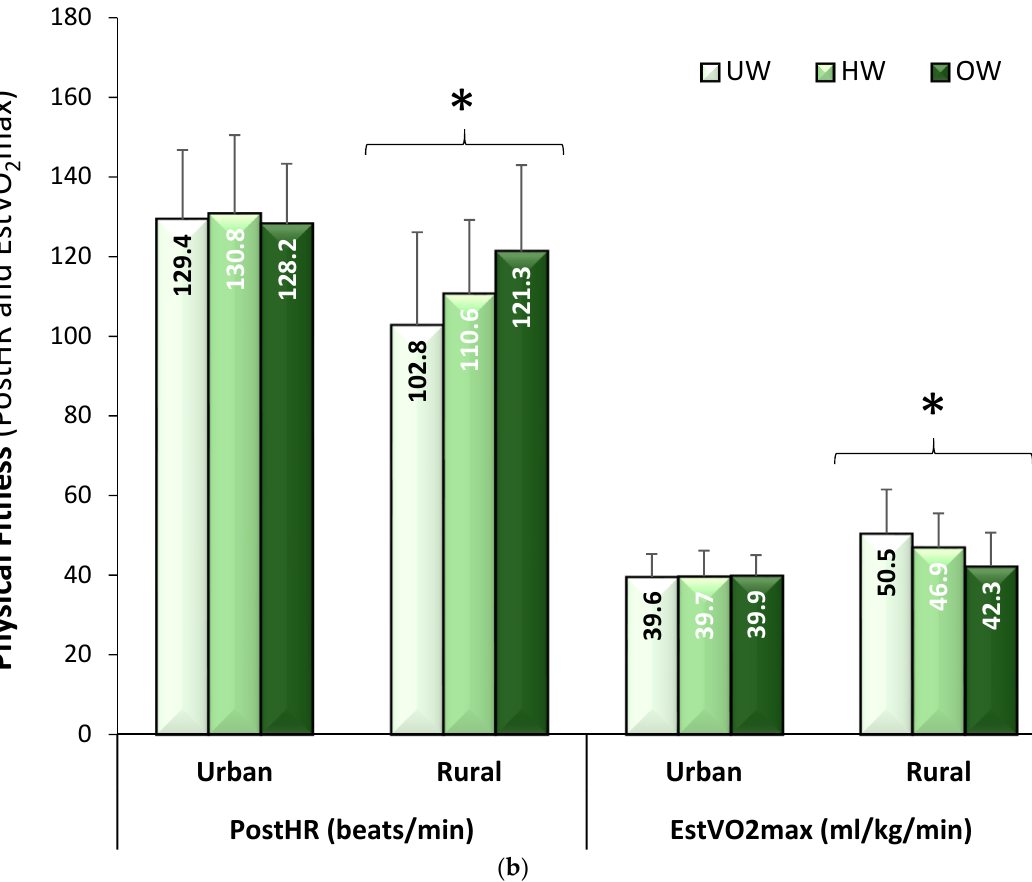
Figure 1. ( a ) Physical fitness levels for male and female adolescents by location, which illustrates that females had consistently lower fitness levels than males, regardless of location; ( b ) Physical fitness levels for underweight (UW), healthy weight (HW), and overweight/obese (OW) adolescents by location, which illustrates that physical fitness levels were significantly higher in UW and HW adolescents compared to OW adolescents only in the rural (southern) Sierra region with no difference in physical fitness across weight status in the urban (northern) Sierra region (Means ± SD). * adjusted p < 0.0001. PostHR: immediate post-exercise heart rate; EstVO 2 max: estimated maximal oxygen consumption.